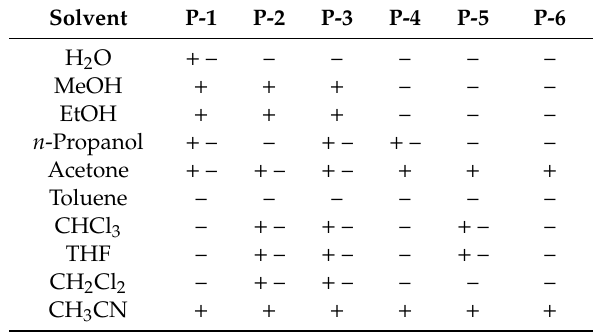
Table 2. Solubility profiles of ionic polymers P-1 to P-6 in different solvents.